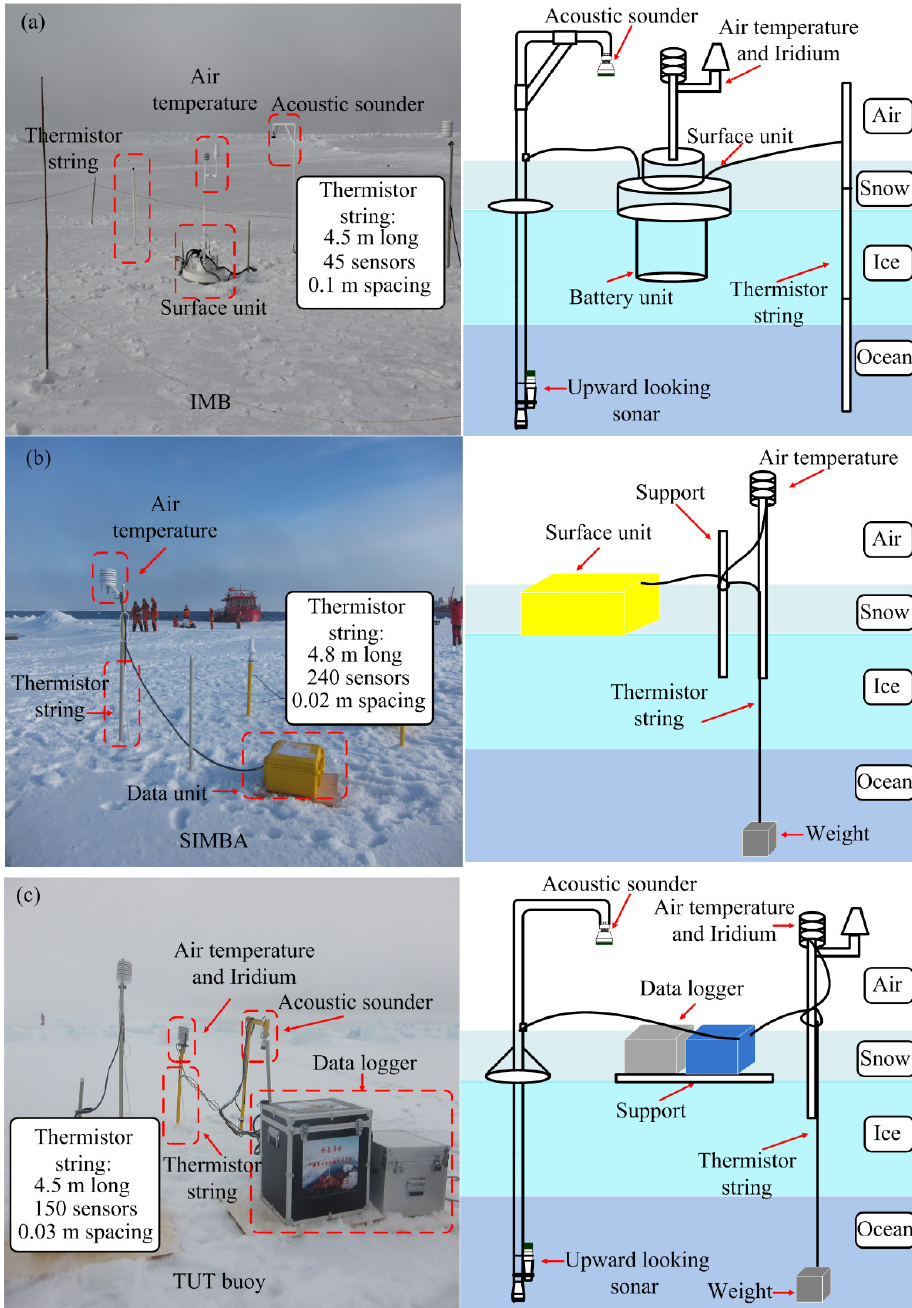
Figure 2. ( a ) The installation of the IMB in the Arctic Ocean during CHINARE-2016 and schematic diagram of the IMB. ( b ) The installation of the SIMBA in the Arctic Ocean during CHINARE-2016 and schematic diagram of the SIMBA. ( c ) The installation of the TUT buoy in the Arctic Ocean during CHINARE-2016 and schematic diagram of the TUT buoy.